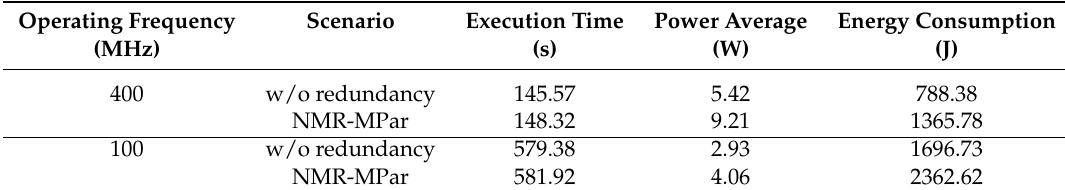
Table 8. Power and energy consumption for the studied scenarios of TSP.